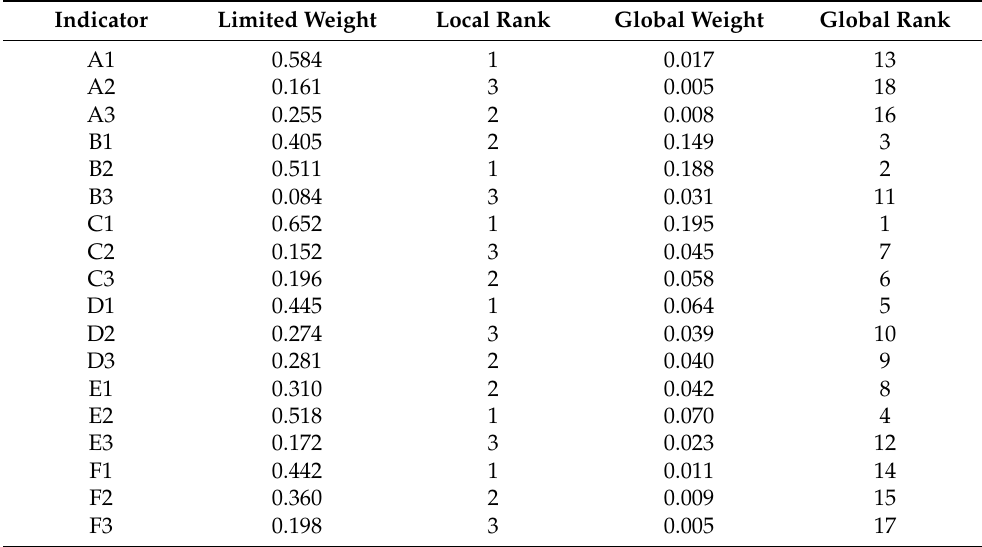
Table 6. The limited weight and global weight for